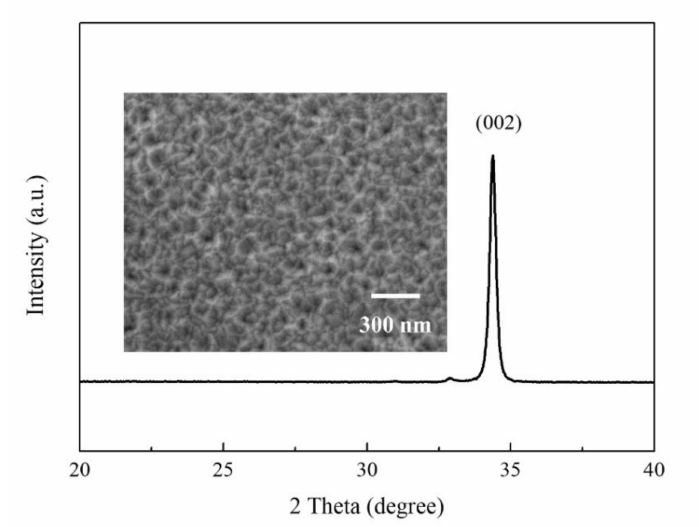
Figure 2. XRD pattern of AZO film (insert image shows the FE-SEM top view image of AZO